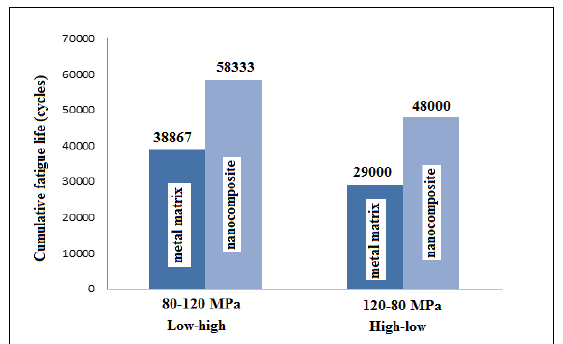
Fig. 4. Improvement of cumulative fatigue life due to 10wt% Al 2 O 3